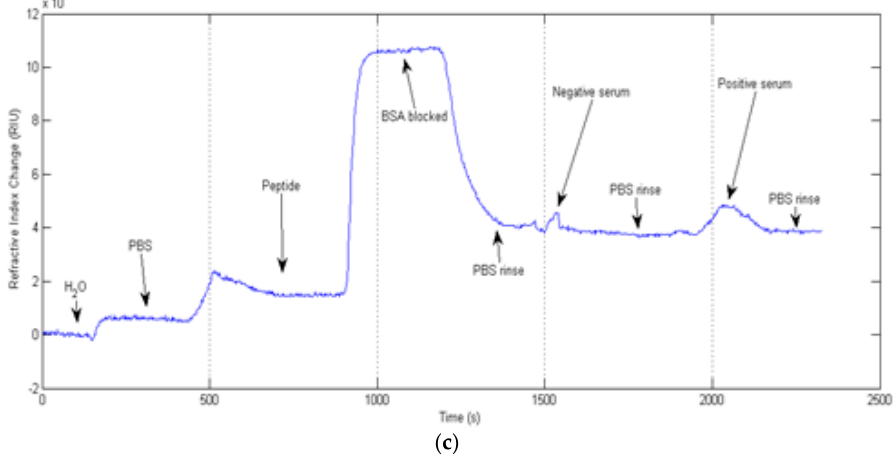
Figure 2. Sensorgrams for ( a ) VIRChip and PPBIO at the ( b ) AIM and ( c ) WIM